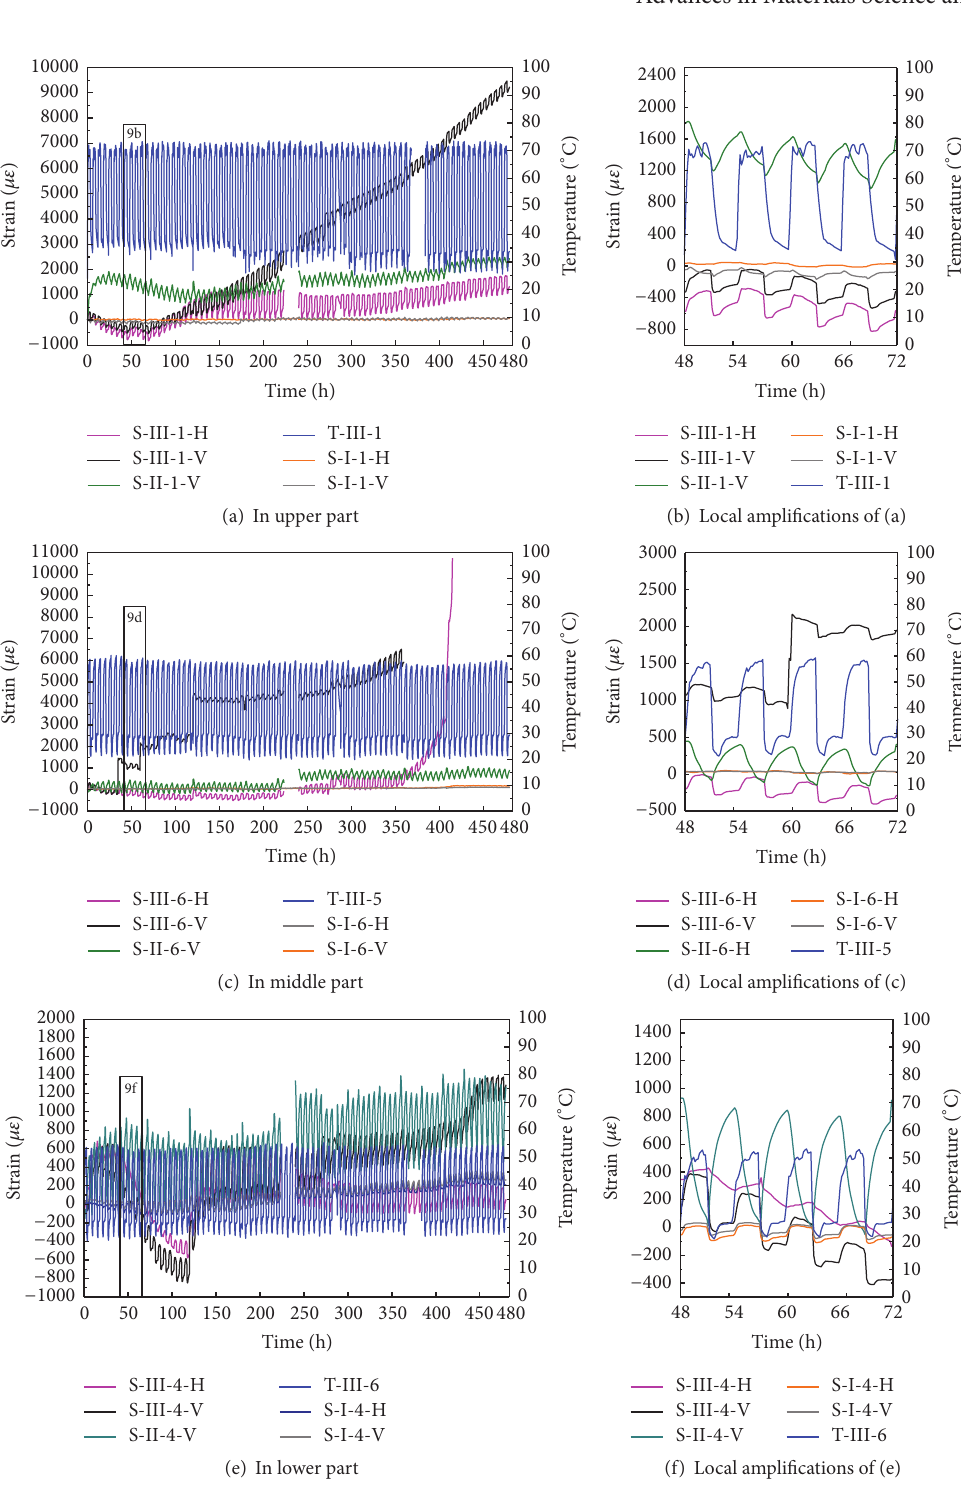
Figure 9: Strain-time-temperature relationship of three